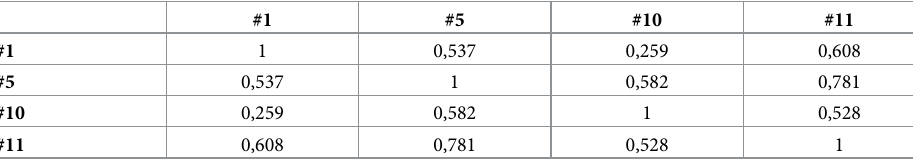
Table 16. Inter-item correlation matrix for subscale 3